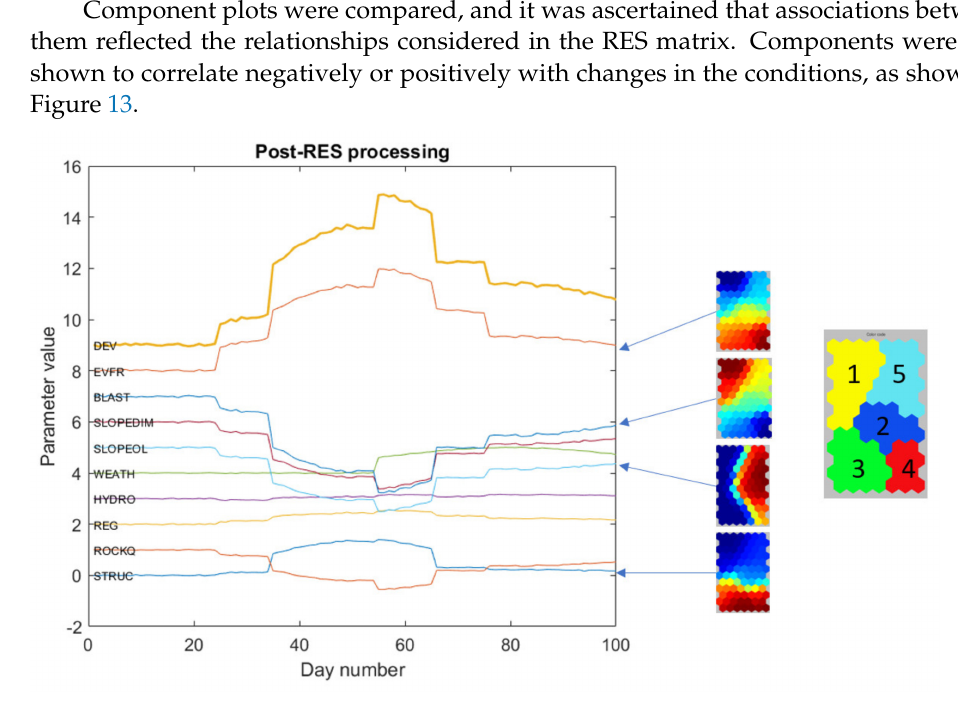
Figure 13. Results of the SOM training show the relationships with selected SOM